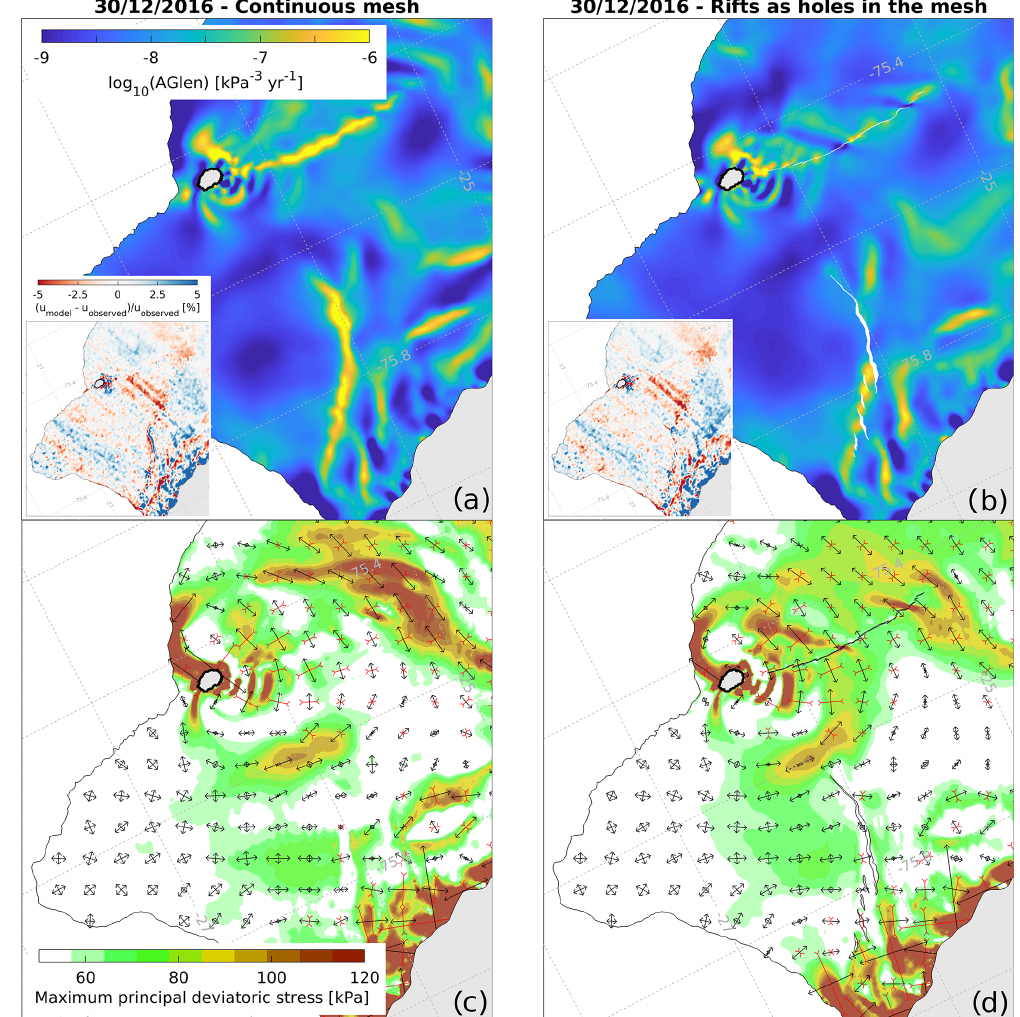
Figure B1. Spatial maps of the rate factor A (a, b) and diagnostic principal stresses (c, d) for the Brunt Ice Shelf on 6 December 2016. Results are based on identical input datasets, but for two different computational meshes: on the left (a, c) , a continuous mesh was used and Chasm 1 and Halloween Crack were filled with ice; on the right (b, d) , rifts were represented as holes in the mesh with ocean boundary